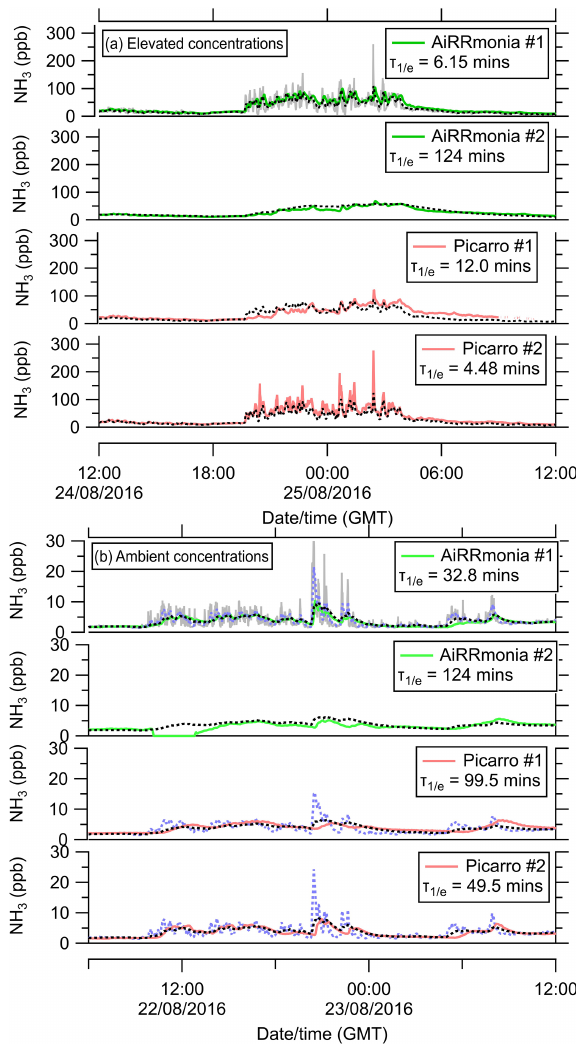
Figure 7. Smoothed time series of miniDOAS #1 (black dotted line) calculated from the 1min miniDOAS #1 signal (grey line) until the time series, fitted eye by eye, is similar to the reporting data of individual instruments. (a) Elevated concentrations following fer- tilisation (fertiliser applied from 11:00 on 23 August 2016), and (b) ambient concentrations. The blue line on panel (b) represents the smoothed time series using the time response derived from the elevated concentrations from panel (a) to visualise the significant additional smoothing encountered under ambient